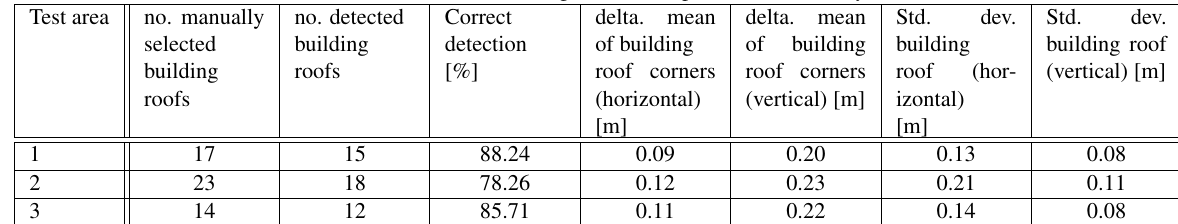
Figure 4: two examples of detecting edges within the masked region from coarse building outline acquisition. Table 1: The statistic of detected building outline compared with manually reference